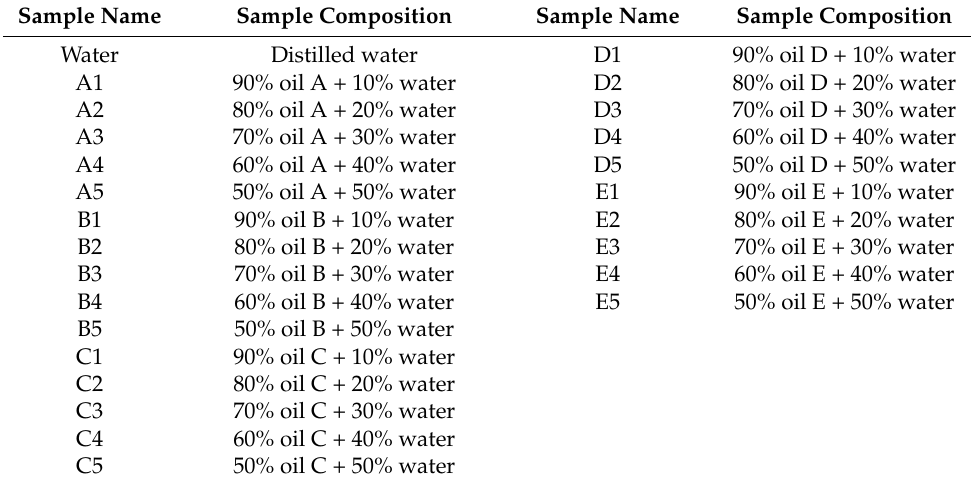
Table 2. Sample compositions for the water–oil mixtures.